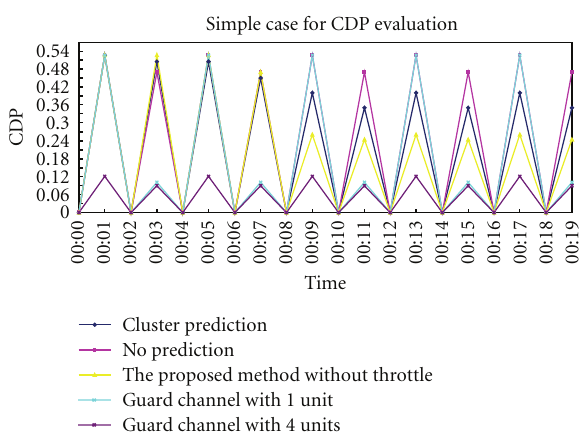
Figure 5: Comparison of CDPs among the proposed method and others for simple case.